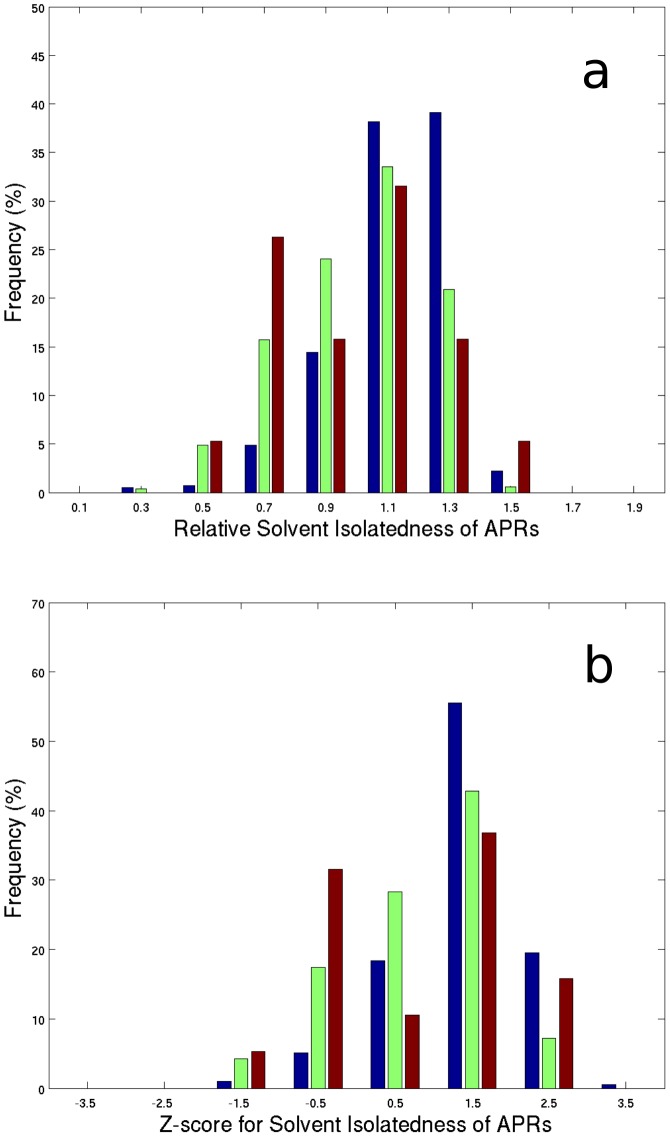
Solvent isolatedness of APRs and Amylsegs in the crystal structures of monomeric proteins from F495 is plotted.(a) Bar diagram showing the relative solvent isolatedness of TANGO predicted APRs (blue bars), WALTZ predicted APRs (green bars) and Amylsegs (red bars). X-axis shows relative solvent isolatedness and Y-axis indicates frequency. Most APRs and Amylsegs contribute more to the stability of native protein structures than expected from equal length segments from their parent proteins. (b) Bar diagram showing Z-scores for significance of solvent isolatedness values for TANGO predicted APRs (blue bars), WALTZ predicted APRs (green bars) and Amylsegs (red bars). X-axis shows the Z-scores and Y-axis indicates frequency. TANGO isolatedness Z-scores have an average of 1.44±0.76 indicating that APR isolatedness values are significant.